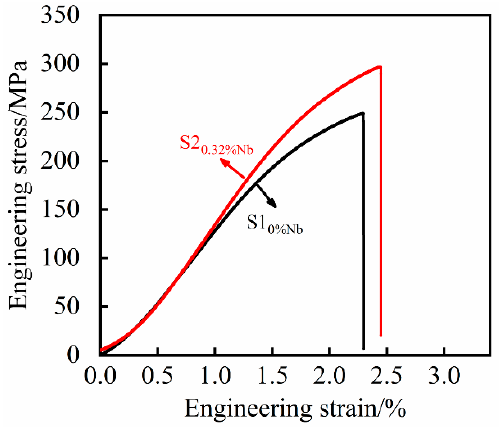
Figure 13. T he engineering stress–strain curves.